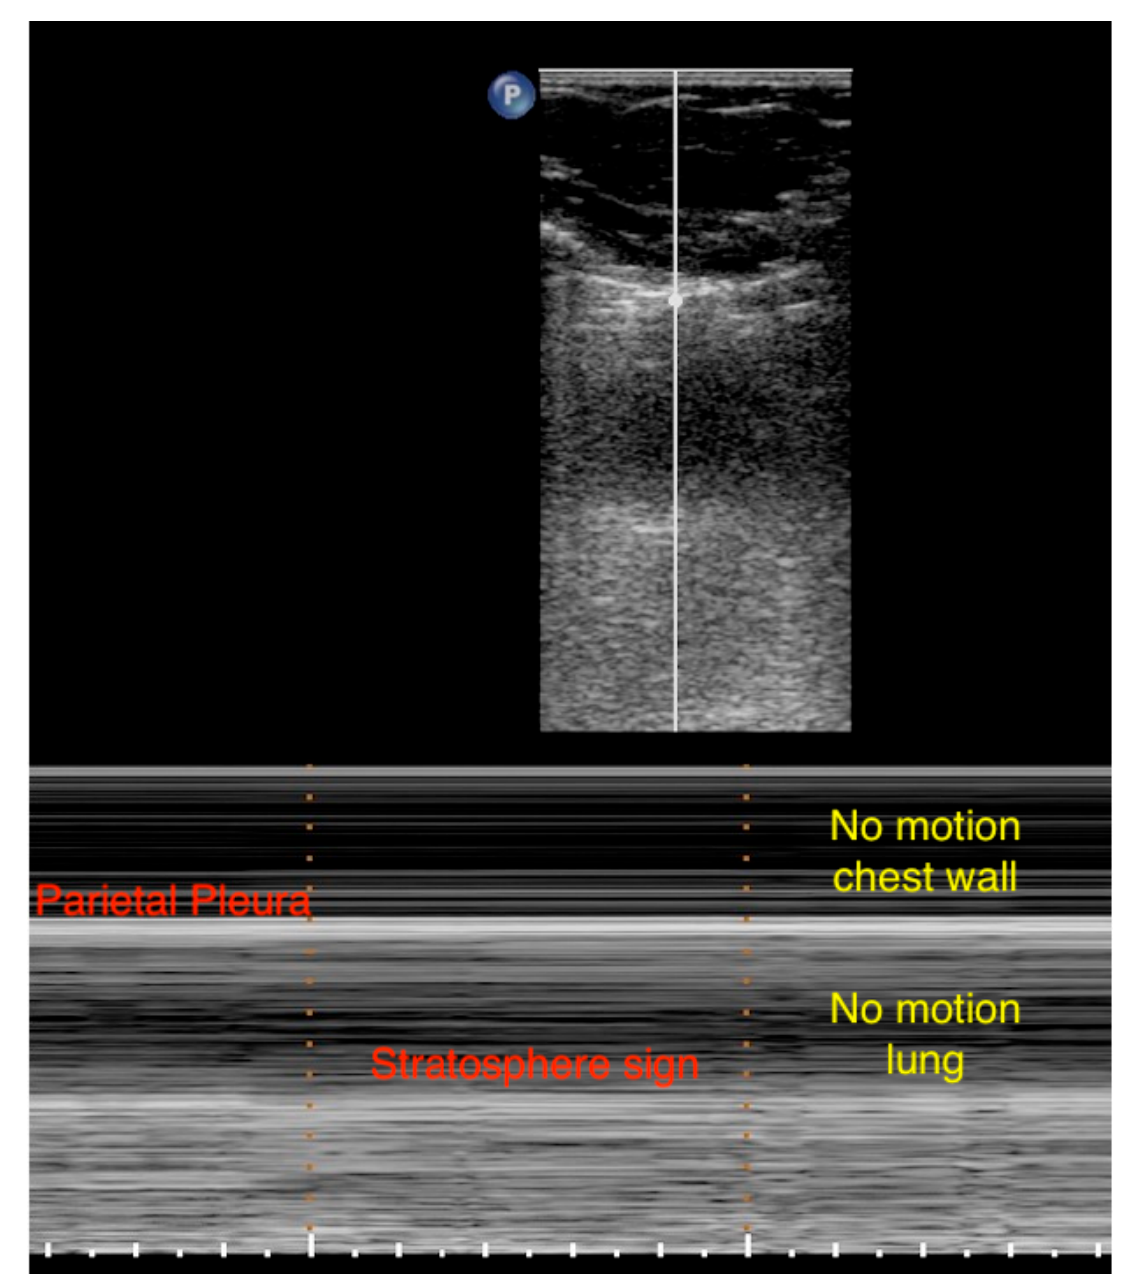
Figure 10. Pneumothorax in M-mode. Parietal pleura visualized below two successive ribs. There was an absence of pleural sliding and seashore signs in M-mode, which indicated the presence of gas effusion. In M-mode, the stratosphere sign and straight horizontal lines above and beneath the pleural line can also be observed, representing the absence of pleural